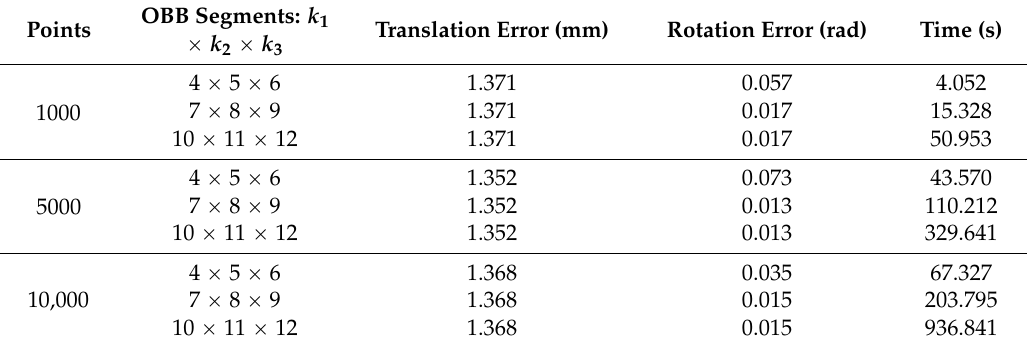
Table 2. Experimental results using the connector model obtained by the proposed coarse registration